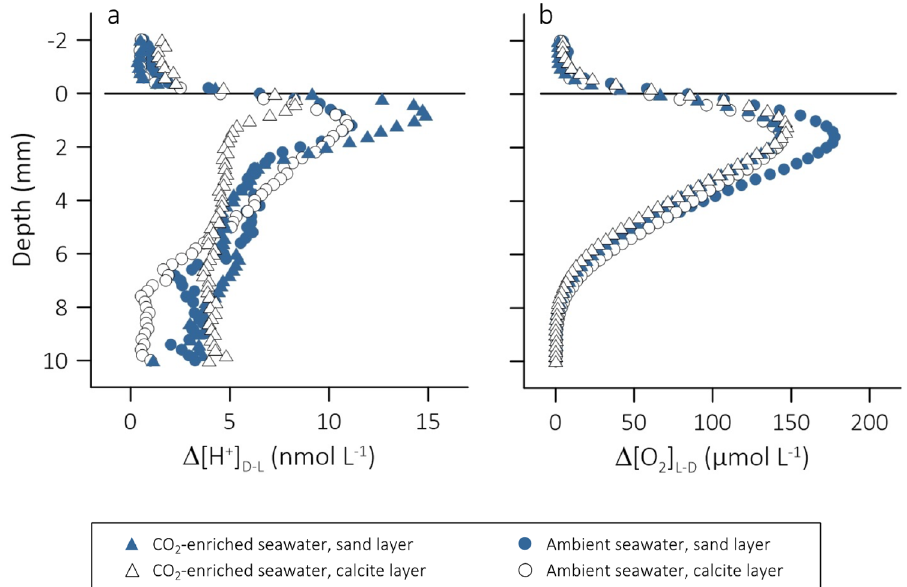
Figure 4. Diel oscillations in porewater ( a ) [H + ] (Δ[H + ] D-L , nmol L −1 ) and ( b ) [O 2 ] (Δ[O 2 ] L-D , µmol L −1 ) as a function of depth in the surface layer of intact cores of subtidal silt sediment submerged in ambient (circles) and CO 2 -enriched (triangles) seawater. A 1 mm surface layer of either sterile sand (filled symbols, Control) or calcite (open symbols, +Calcite) was added to the sediment cores. The horizontal line at 0 mm depth indicates the position of the sediment surface.